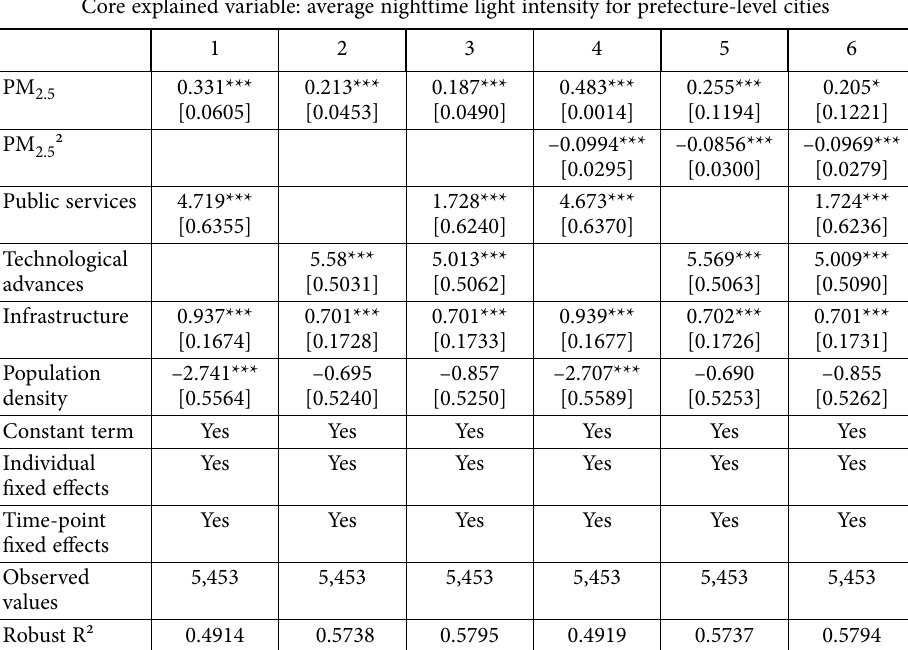
Table 3. Baseline regression results for air pollution and its effect on economic development Core explained variable: average nighttime light intensity for prefecture-level